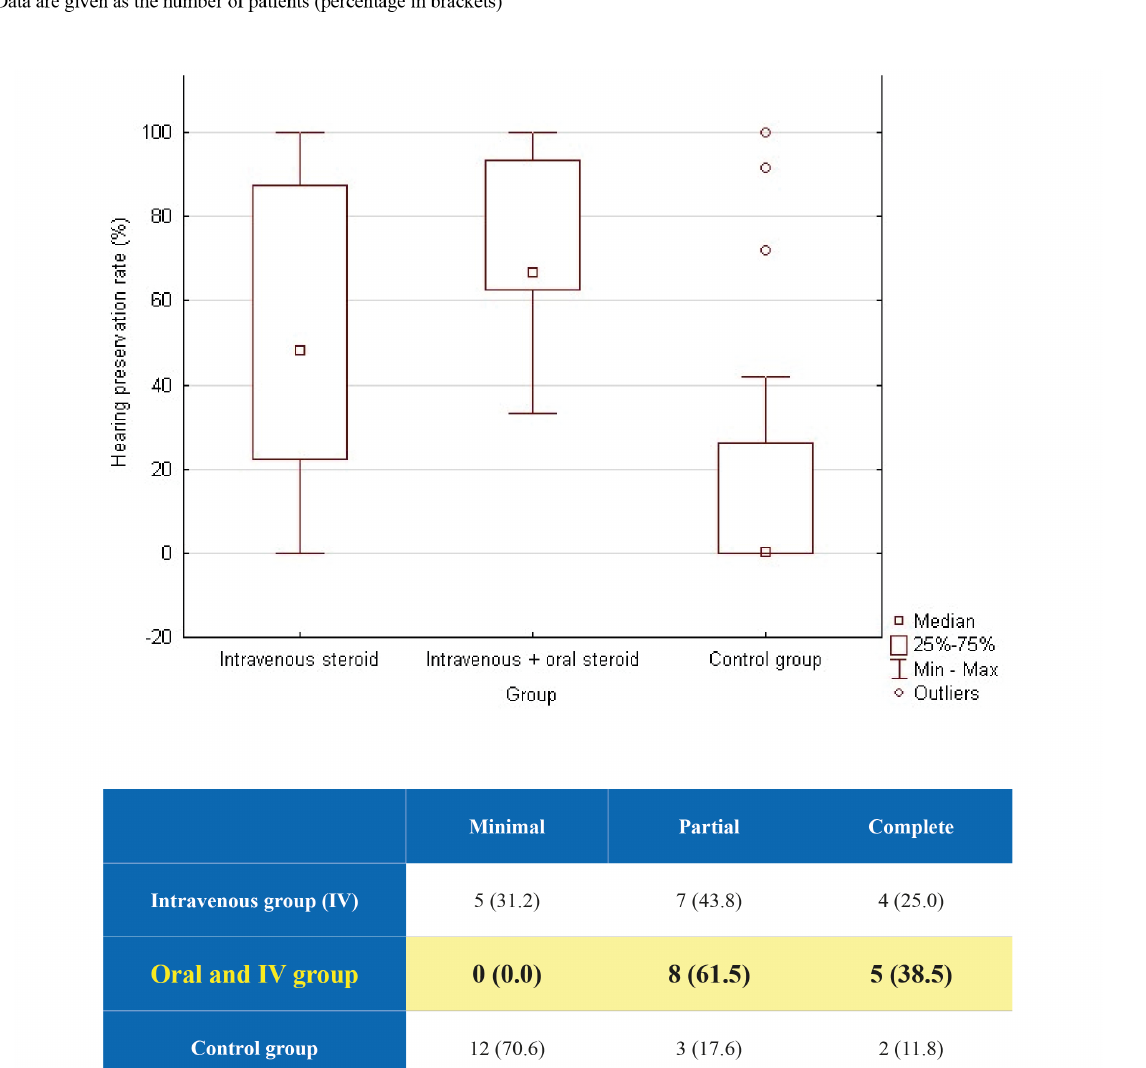
FIGURE 5 - Hearing preservation (HP) rate in the study